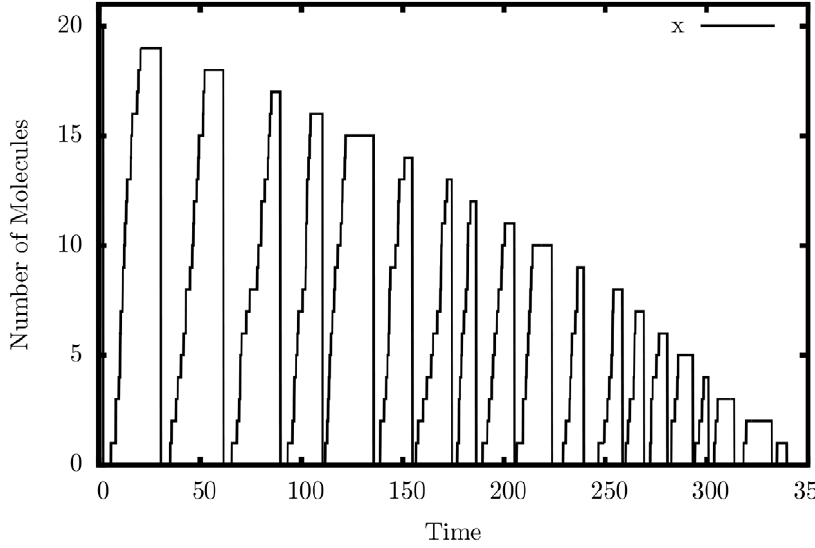
Figure 6. Simulation output of the decrement construct. x ~ 20 .